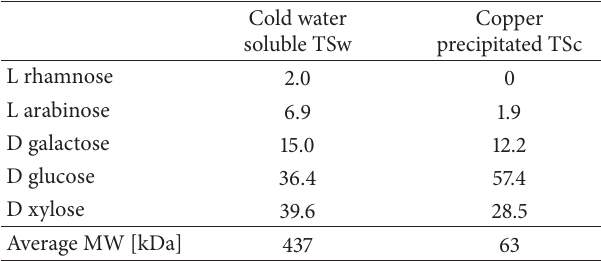
Table 1: Monosaccharide composition of TSw and TSc from T. indica seeds determined by HPAEC-PAD and CE after total hydrol- ysis with TFA (%, w/w). The average MW of TSw and TSc was determined by GFC against dextrans of known molecular weight on Sepharose CL-6B. Cold water soluble TSw